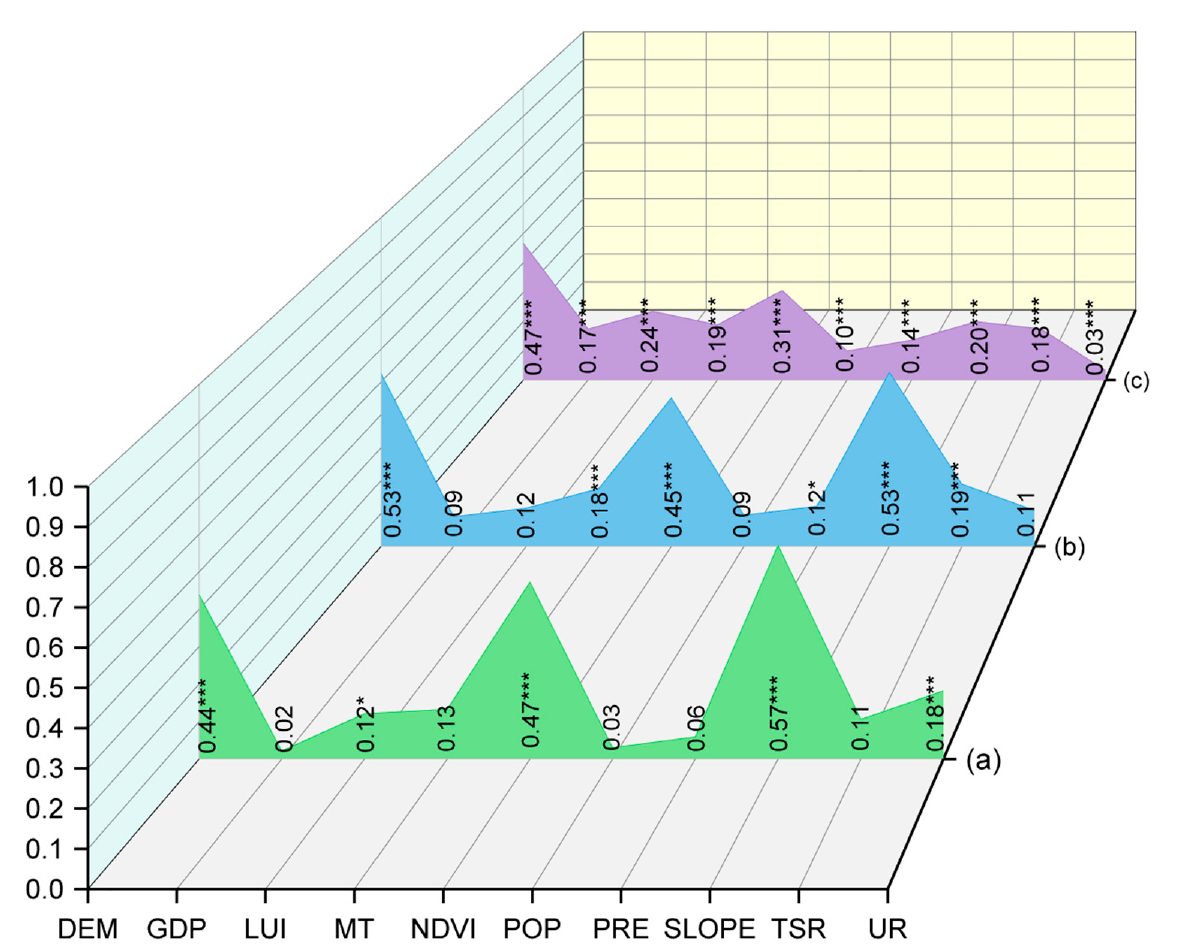
Figure 6. Factor detector results; *** means that q value is significant at the 0.001 level; * means that q value is significant at the 0.05 level; ( a ) county scale, ( b ) watershed scale, ( c ) 1 km grid scale.